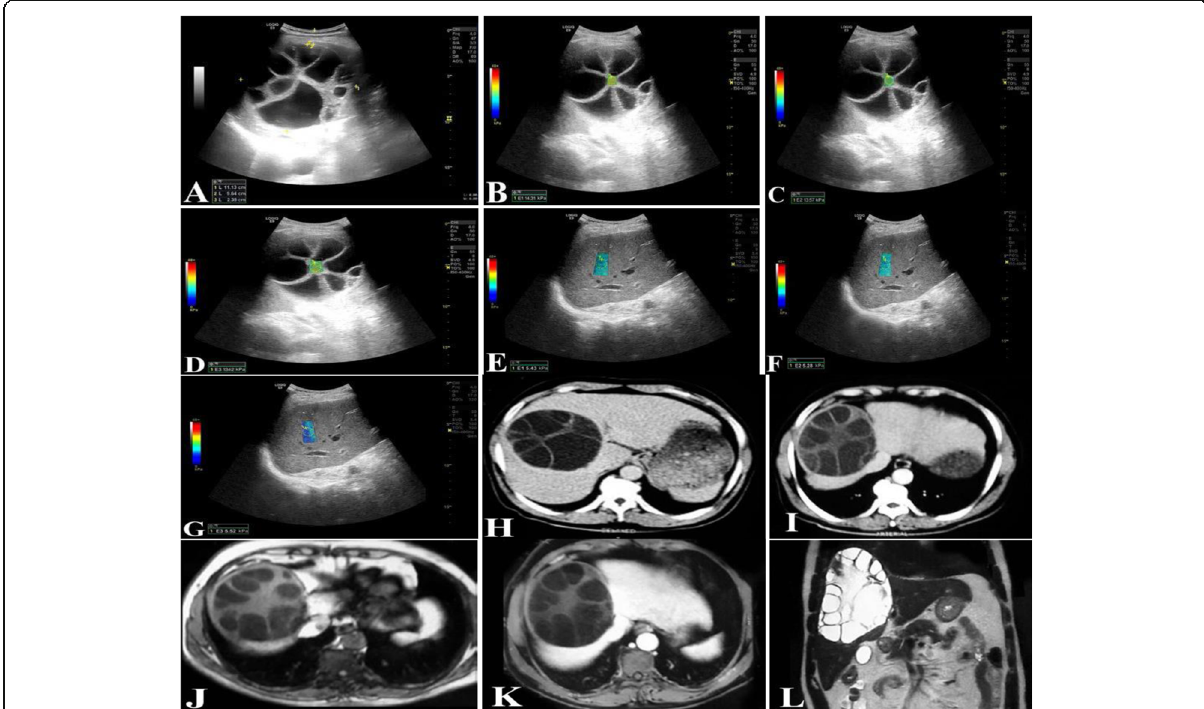
Fig. 3 Fifty-eight years old male patient presented with abdominal fullness. Imaging findings: grey scale B-mode Ultrasonography ( a ): normal sized liver with a well-defined anechoic focal lesion with septations inside seen occupying most of the right liver lobe measuring 11.1 × 9.6 cm with 2.3 cm depth from the skin. ϖ Color-coded shear wave sono-elastography: measurements are taken in the septations showed yellow green color ( b , c , d ), while the liver parenchyma showed dark blue color ( e , f , g ). ϖ Shear wave sono-elastography stiffness values of the focal lesion: E1 = 14.31 kPa ( b ), E2 = 13.57 kPa ( c ), and E3 = 13.42kPa ( d ). Calculated average stiffness value of the lesion = 13.76 kPa. ϖ Shear wave sono- elastography stiffness values of the parenchyma: E1 = 5.43 kPa ( e ), E2 = 5.28 kPa ( f ), and E3 = 5.52 kPa ( g ). Calculated average stiffness value of the parenchyma = 5.41 kPa. Lesion/parenchyma stiffness ratio = 2.54. ϖ Axial contrast enhanced CT study (non-contrast ( h ), post-contrast ( i )): a large well-defined non-enhancing multilocular cystic lesion with multiple septae and daughter cysts. It is seen occupying most of the right liver lobe. ϖ Contrast enhanced MRI study (non-contrast axial T1 ( j ), post-contrast fat sat T1 WI ( k ), and non-contrast coronal T2 WI ( l )): a large well-defined non-enhancing multilocular cystic lesion with multiple septae and daughter cysts. It is seen occupying most of the right liver lobe. It displays low SI on T1 WI, high SI on T2 WI images, and shows no enhancement on post-contrast T1WI. ϖ Diagnosis: hydatid cyst